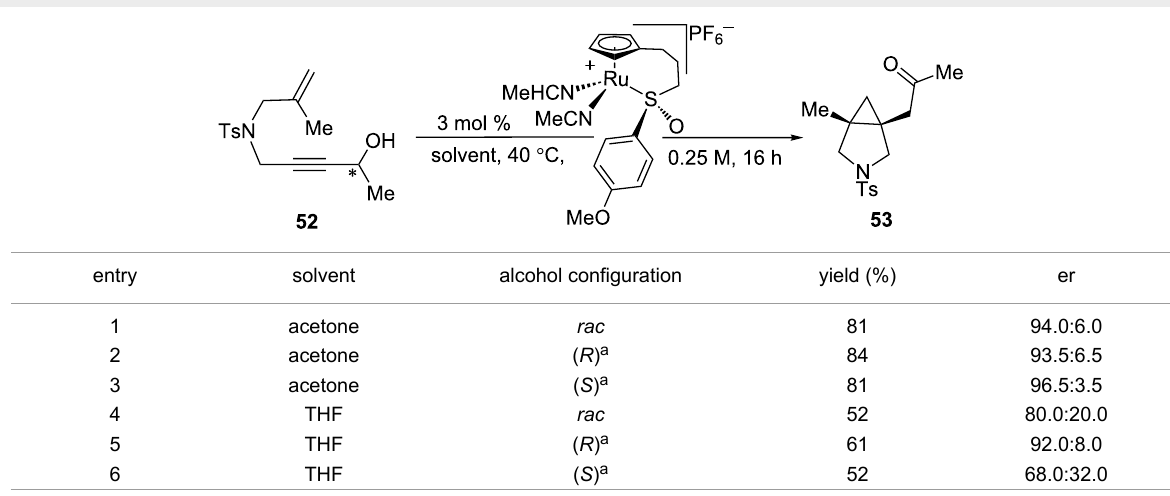
Table 8: Effect of propargylic stereocenter on